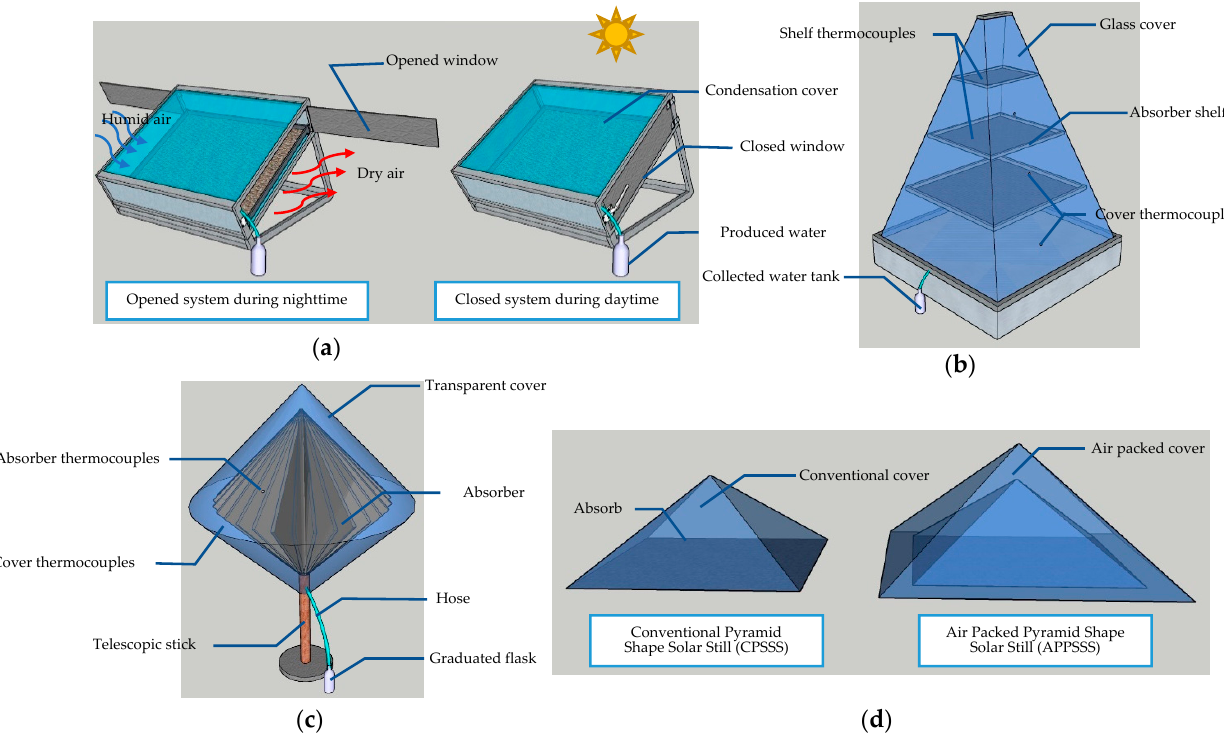
Figure 1. ( a ) Solar glass desiccant box type system (SGDBS), adopted from [20]; ( b ) Trapezoidal prism solar collector, adopted from [21]; ( c ) Double-faced conical finned absorber, adopted from [22] and ( d ) traditional pyramid-shaped solar still and air-filled pyramid-shaped solar still, adopted from